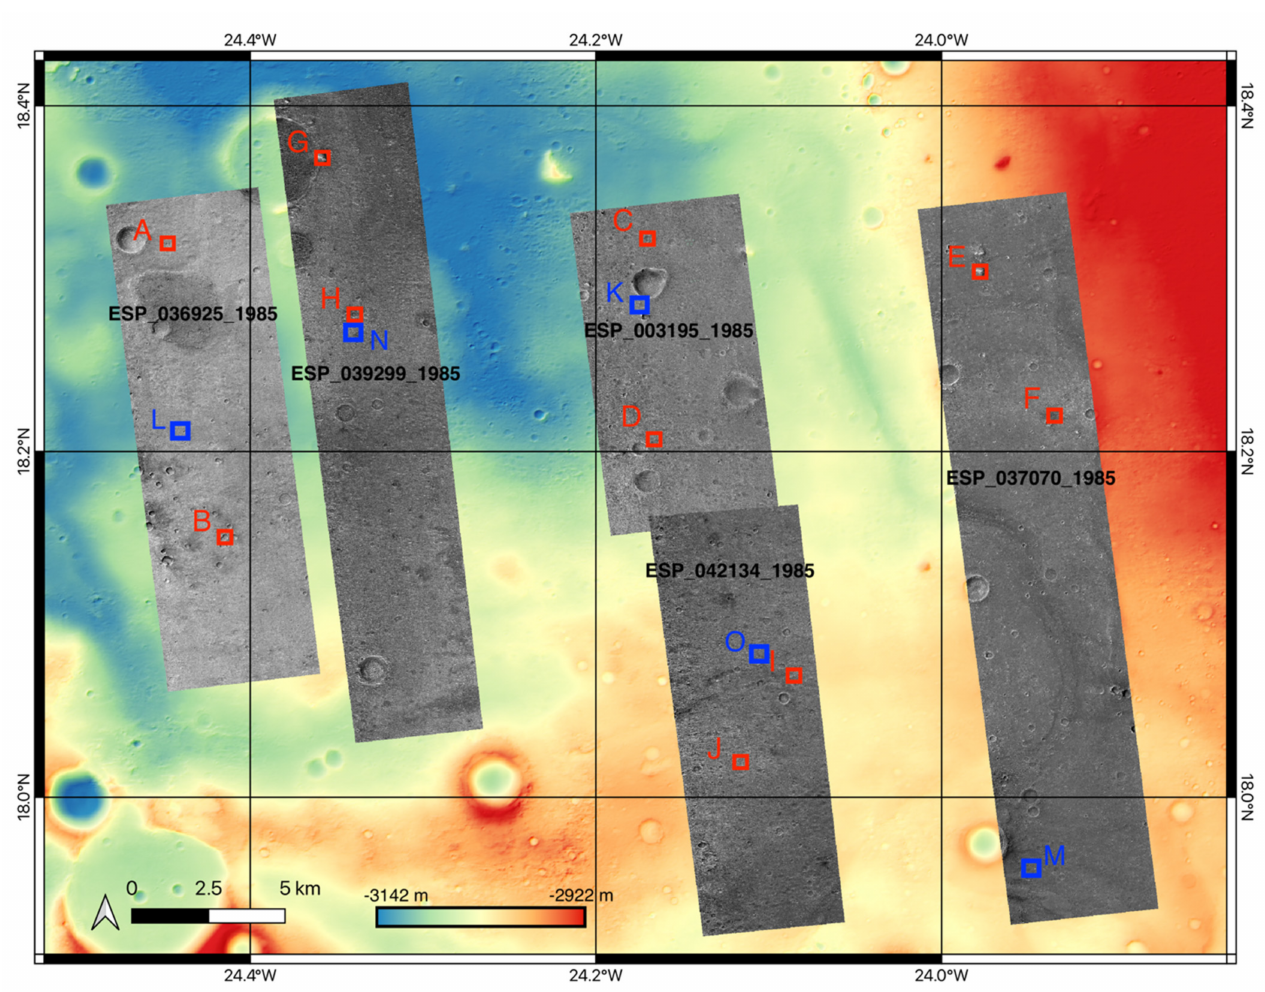
Figure 10. An overview of the test HiRISE images superimposed on the basemap MADNet 1.0 CTX DTM mosaic at Oxia Planum. The red boxes show locations of the zoom-in views (from area-A to area-J) that are illustrated in Section 3.1. The blue boxes show locations of the crater counting areas (from area-K to area-O) that are demonstrated in Section